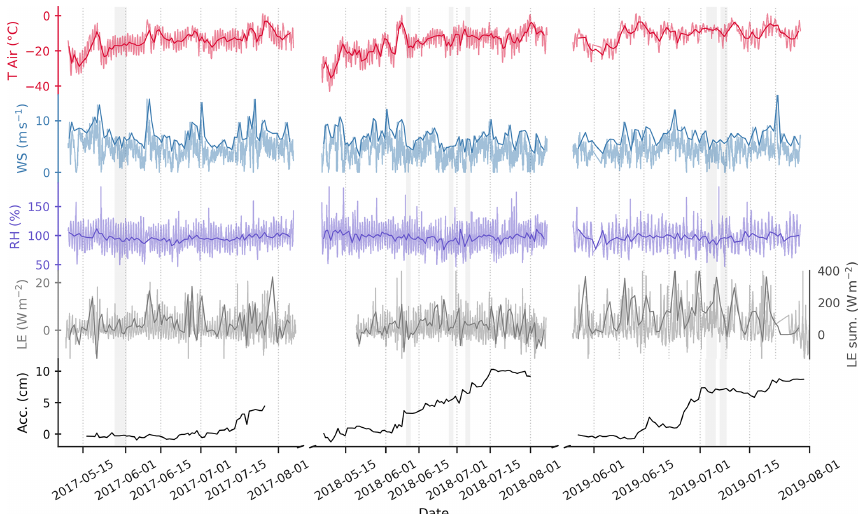
Figure 2. Time series of the ambient conditions during the sampling periods. Data cover the specific sampling periods each year. The 10min mean data from the AWS are presented for air temperature, wind speed and relative humidity. Mean values (bold lines) are shown for air temperature and relative humidity, while daily maximum is shown for wind speed. Latent heat flux data are 30min averages from the eddy covariance tower, with the daily sum shown in bold. Snow accumulation is presented in the lower panel as the daily mean over the 10 sampling sites (see Sect. 2.2). Grey bars indicate the derived SSA decay